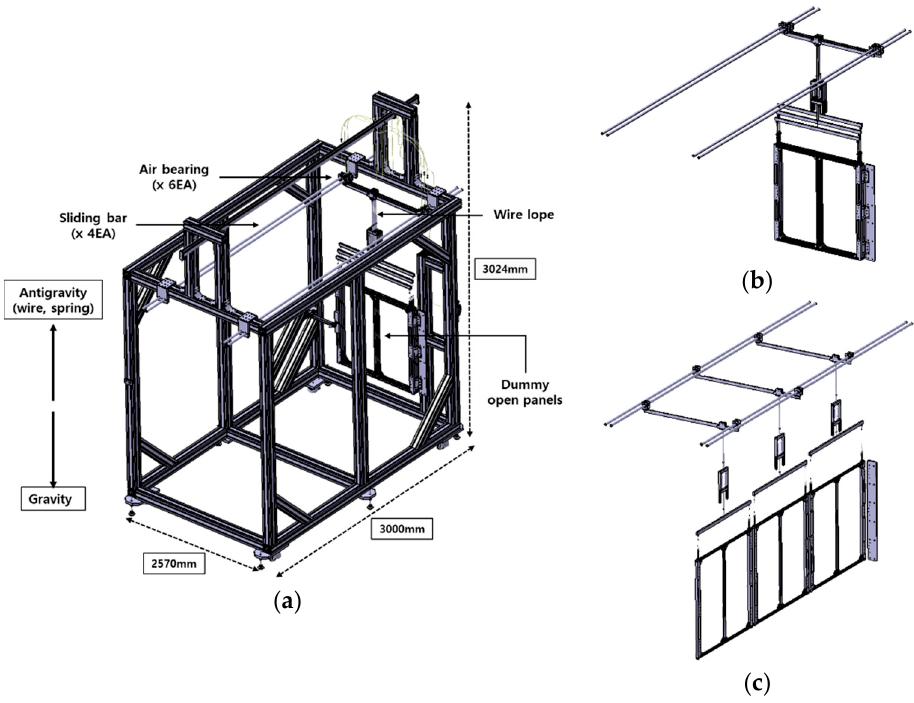
Figure 6. Configuration of the Zero-G device: ( a ) schematic view of Zero-G device, ( b ) stowed configuration (frames were hidden), ( c ) deployed configuration (frames were hidden).